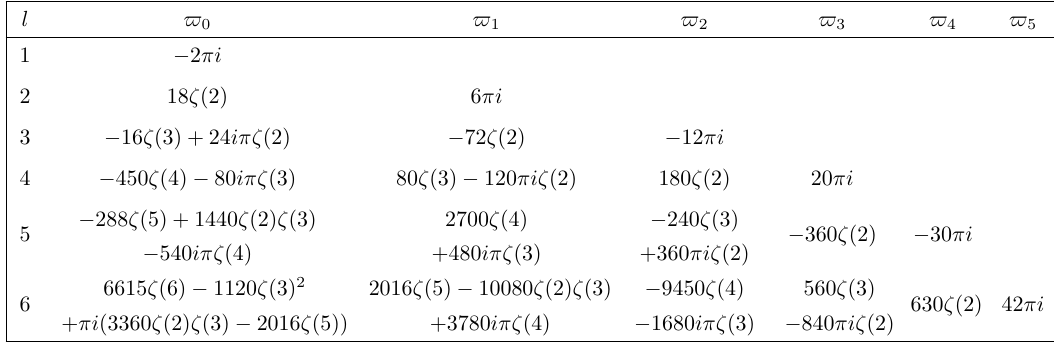
for the equal mass Feynman integral w.r.t. the k